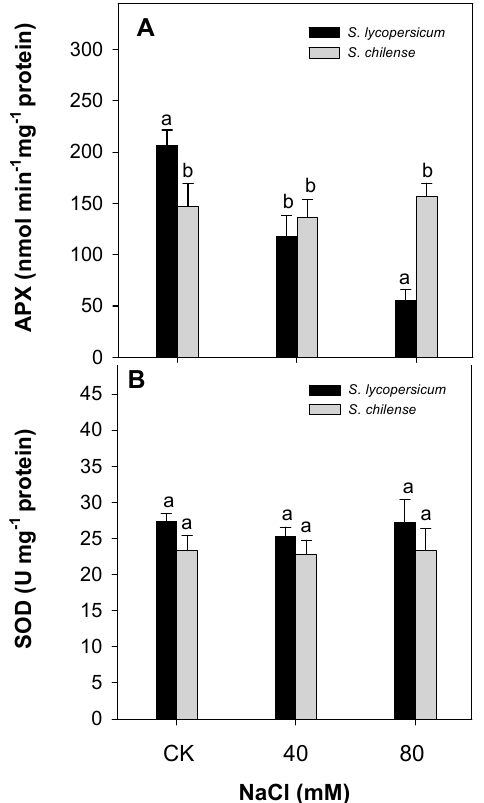
Figure 4. Ascorbate peroxidase activity (APX) (nmol min − 1 mg − 1 protein; ( A )) and superoxide dismutase (SOD) (U mg − 1 protein; ( B )) enzymatic activities in two species of tomato (cultivated Solanum lycopersicum and wild-relative S. chilense ) cultivated for 112 days in nutrient solution containing 0 (control treatment, CK), 40 or 80 mM NaCl. Each value represents the mean ± SE ( n = 6). Lower-case letters indicate differences ( p ≤ 0.05, Duncan test) between treatments and species.